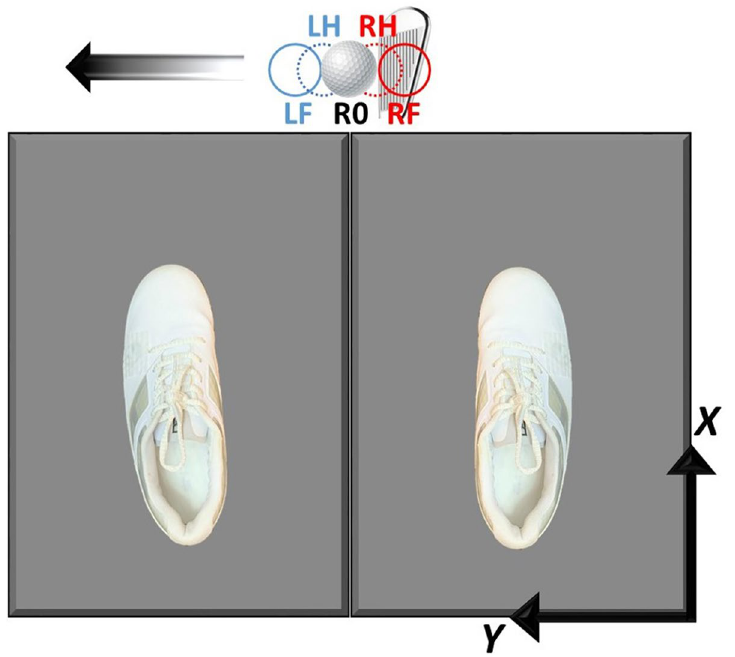
Figure 1. Participants were standing on 2 square force platforms and executed 5 shots for 5 different ball positions along mediolateral direction. LF, LH, R0, RH, and RF stand for left-full position (4.27 cm left from the preferred ball position), left-half position (2.14 cm left from the preferred ball position), reference ball position (i.e. 0 cm at the preferred ball position or the reference ball position), right-half position (2.14 cm right from the preferred ball position), and right-full position (4.27 cm right from the preferred ball position), respectively. The positive Z direction follows the right-hand-thumb rule.